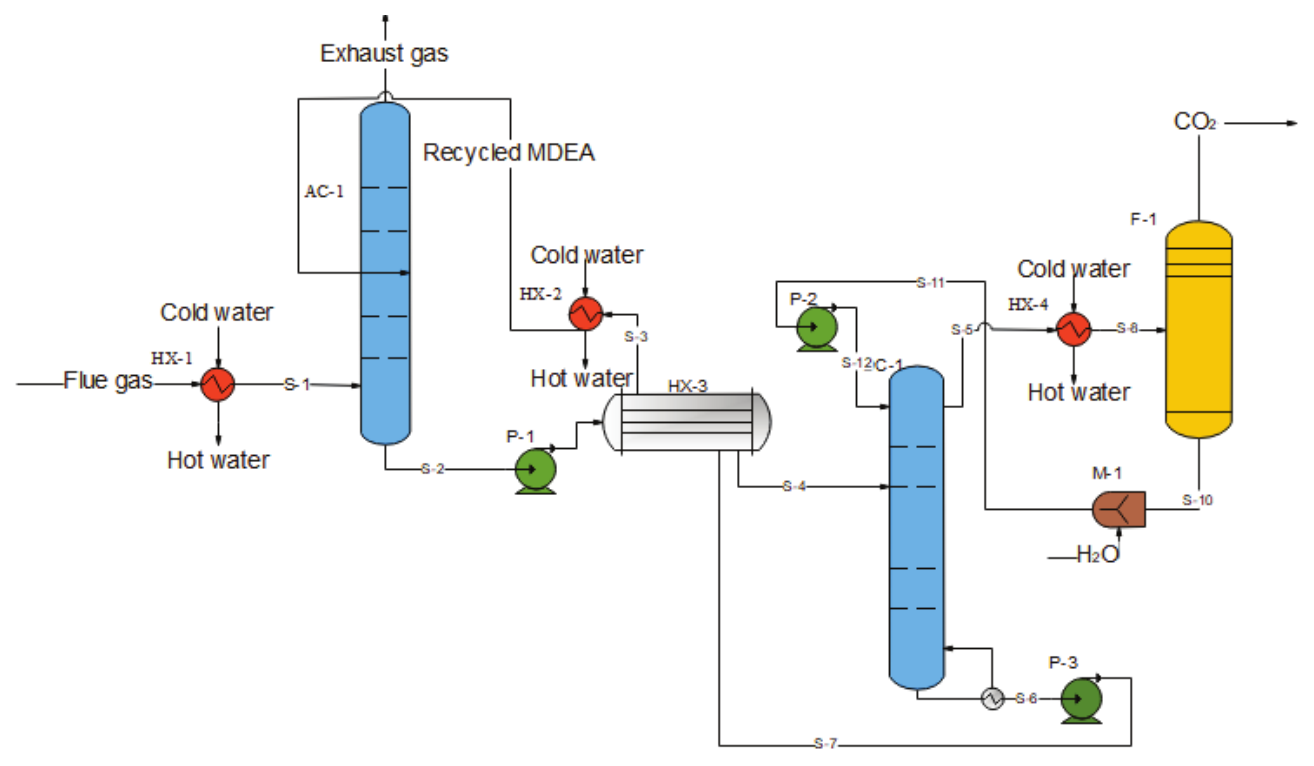
Fig. 3 – Schematic representation of CO